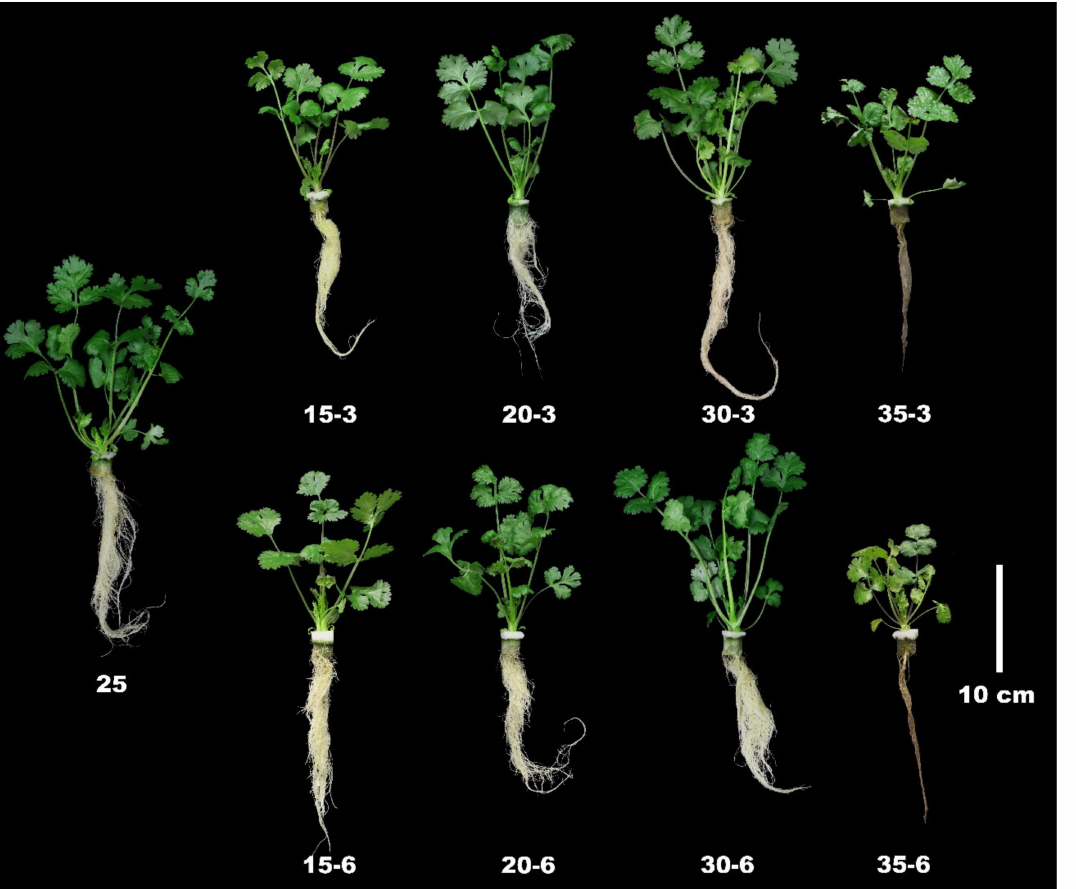
Figure 2. Coriander plants grown under nine di ff erent combinations of RZT and stress period for 18 days after transplanting. Treatment code: “25”, “15”, “20”, “30”, or “35” denotes an RZT of 25 ◦ C, 15 ◦ C, 20 ◦ C, 30 ◦ C, or 35 ◦ C, respectively; “3” or “6” denotes stress period of 3 or 6 days, respectively.